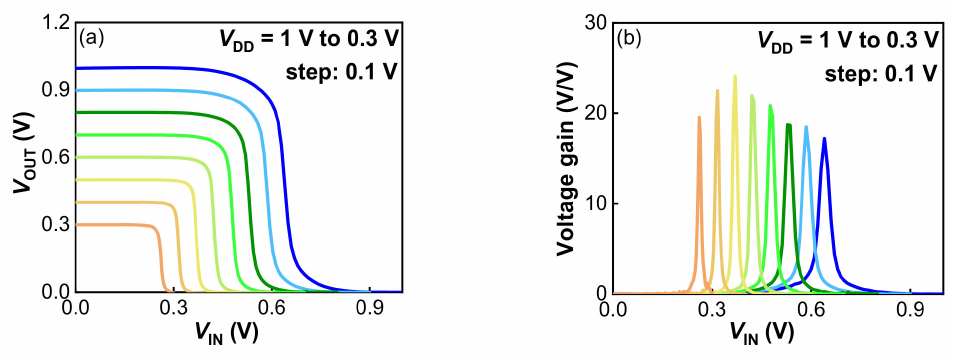
Figure 8. ( a ) Inverter VTC at V DD ranging from 1 V down to 0.3 V, ( b ) Corresponding voltage gains.